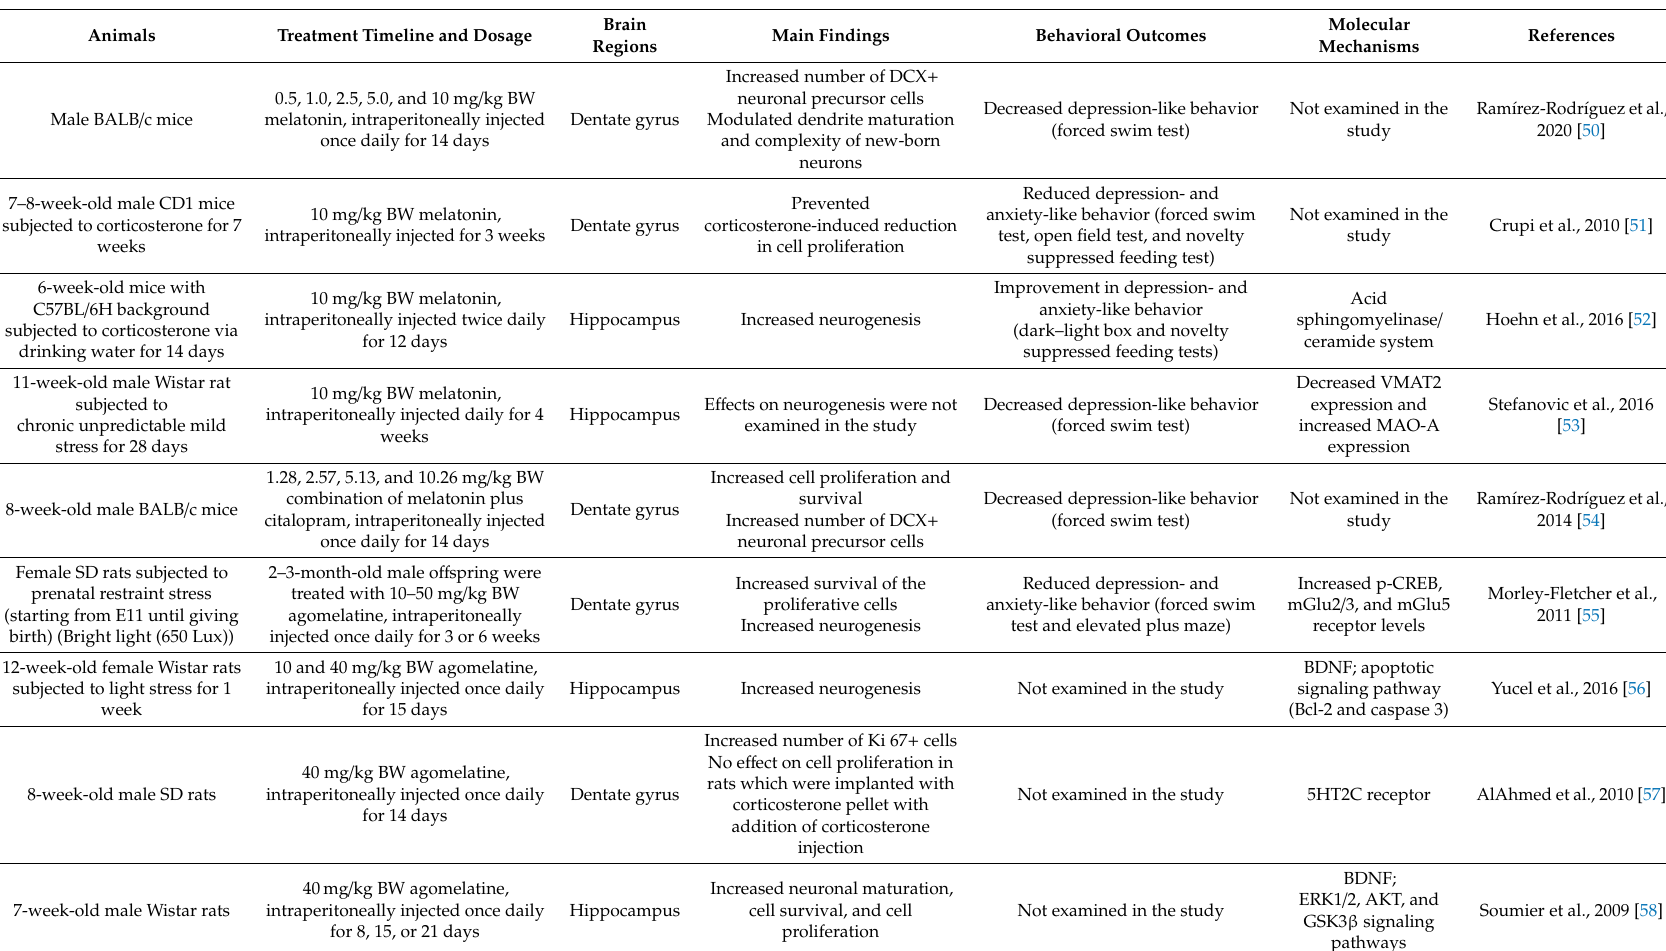
Table 3. Table showing the main findings regarding the e ff ects of melatonin and its receptor agonist on neurogenesis in depression and the respective molecular mechanisms in the in vivo